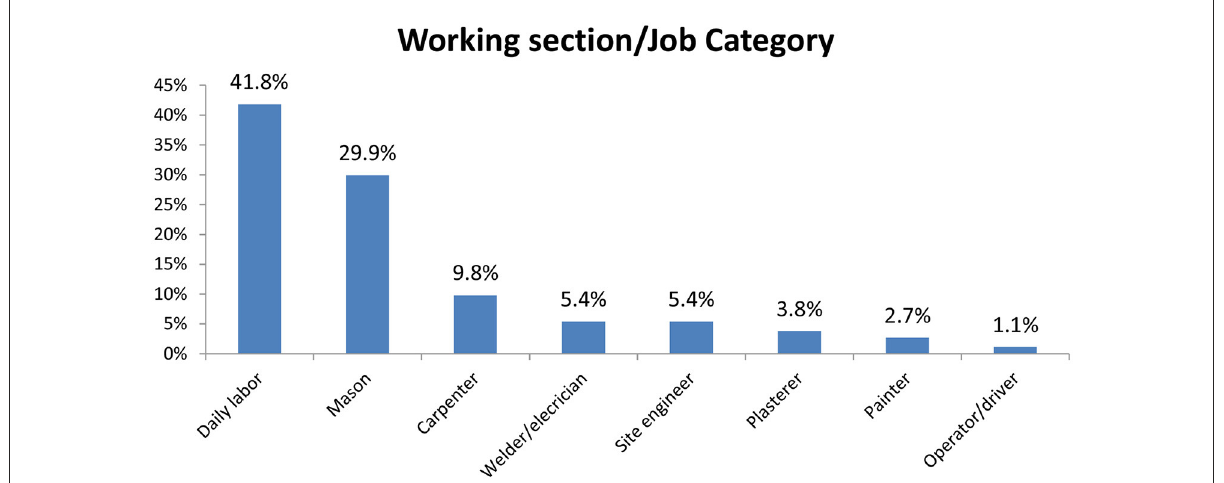
FIGURE1 The working section/job category of the Bure industry park construction workers in Northwest